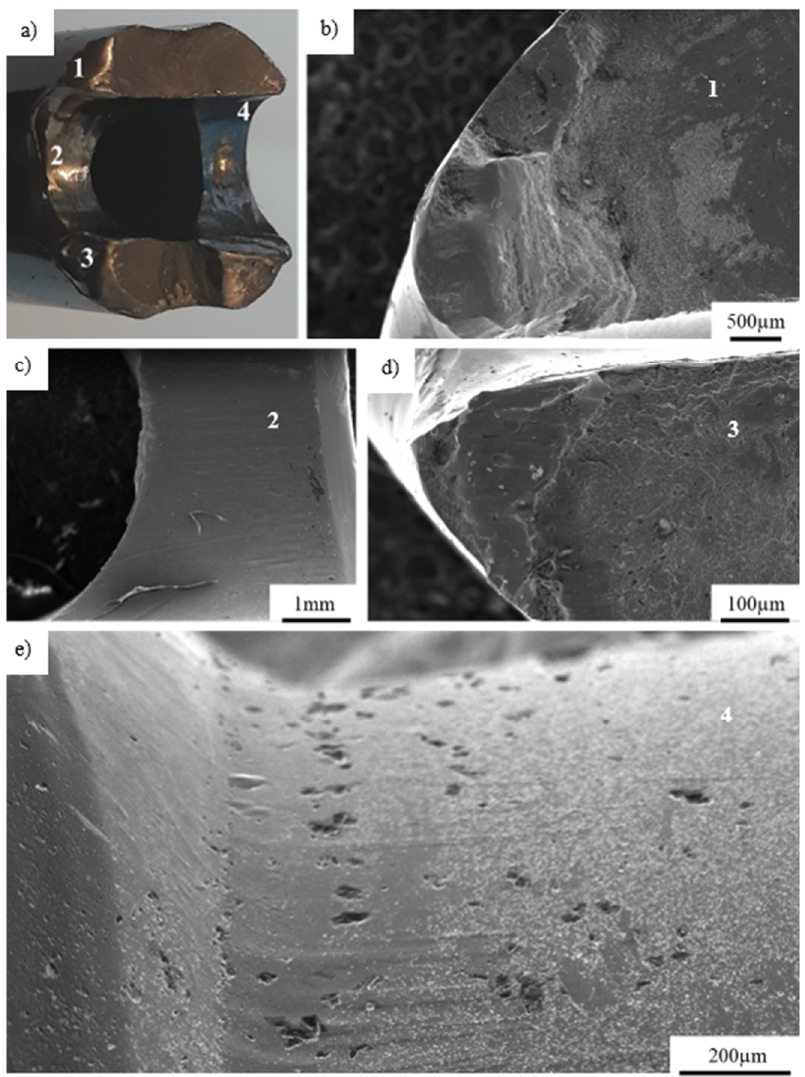
Figure 12. Macroscopic view of the fracture surface with marked areas of SEM inspection ( a ); the edge of fractured implant ( b ); cracks observed in the central part of hole ( c ); the second edge of fractured implant ( d ); micropores found on the edge of the fractured implant ( e ).